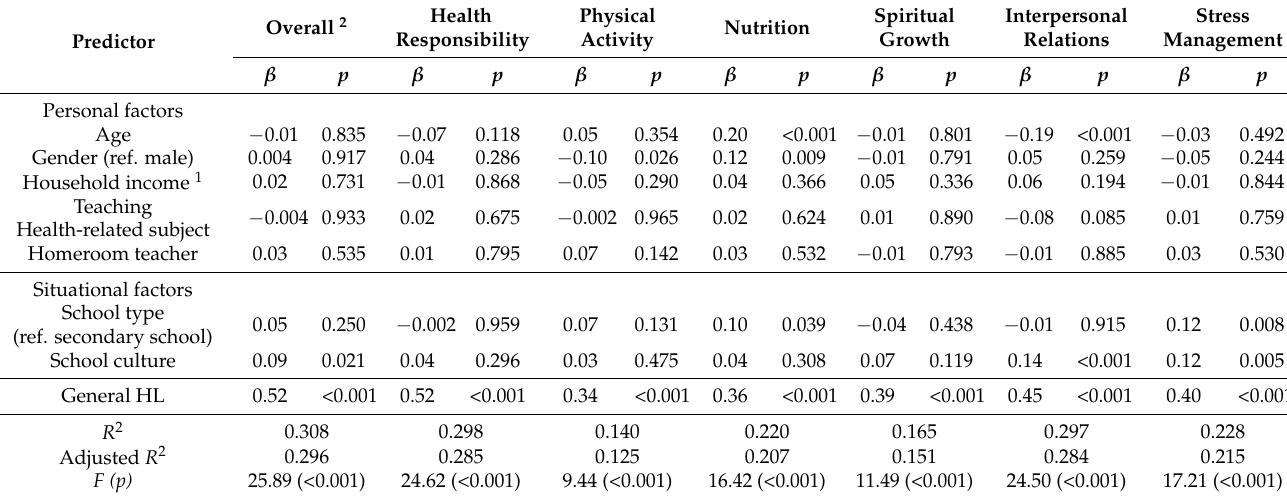
Table 4. Multiple regression analysis predictors of health-promoting behaviors among teachers by Health-Promoting Lifestyle Profile II (HPLP-II)